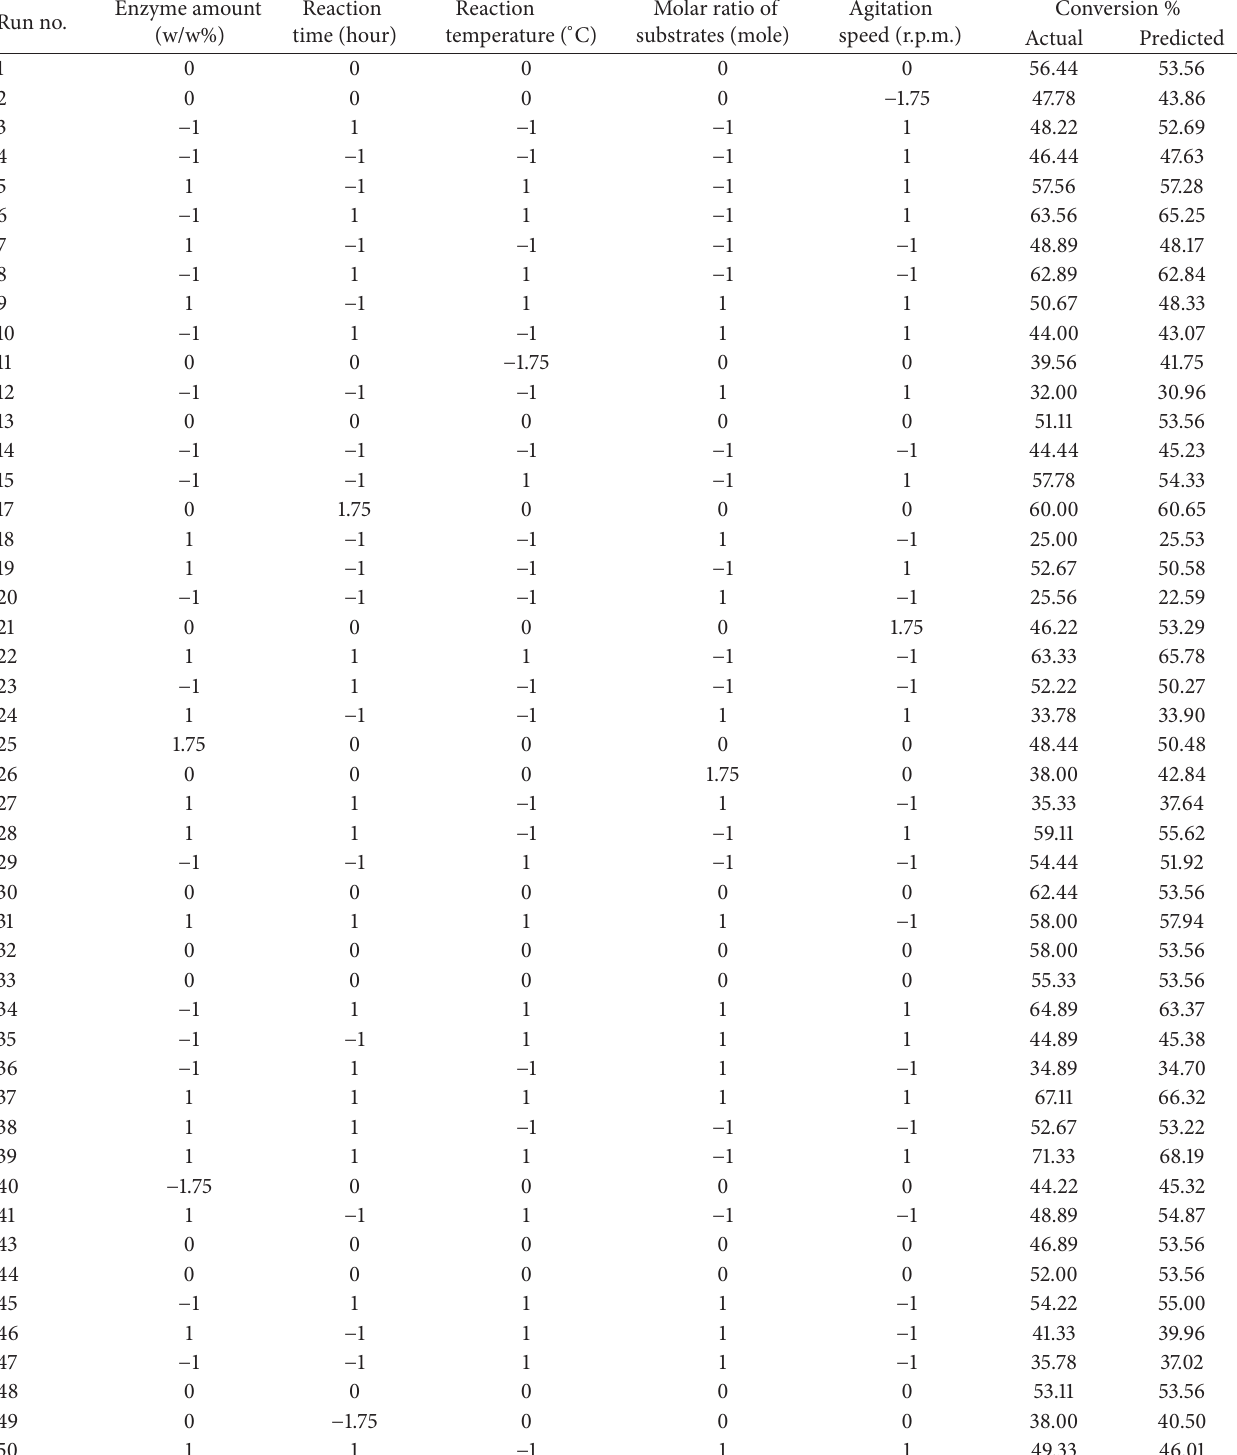
Table 4: Central composite design matrix (coded) and result for the model of TEA-based esterquat synthesis. Run